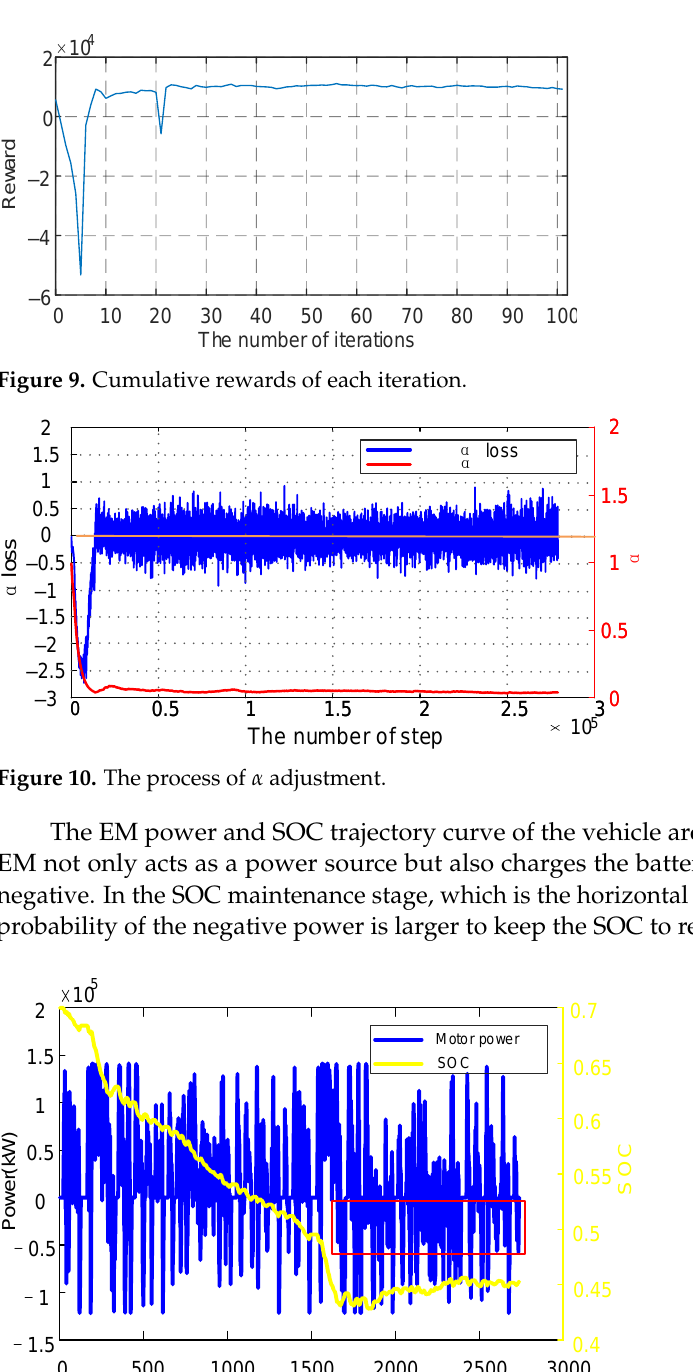
Figure 13. With the increase in training, the fuel consumption per 100 km tends to